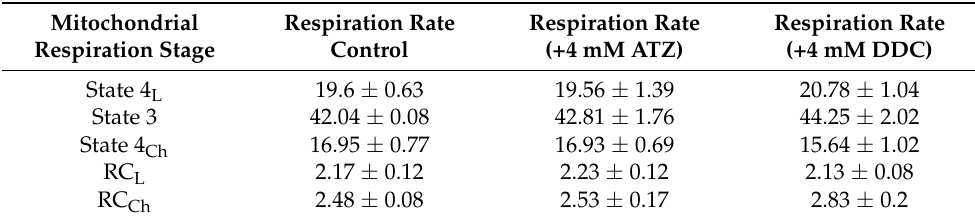
Table 1. The effect of the antioxidant enzyme inhibitors on E. magnusii yeast mitochondria cou- pling